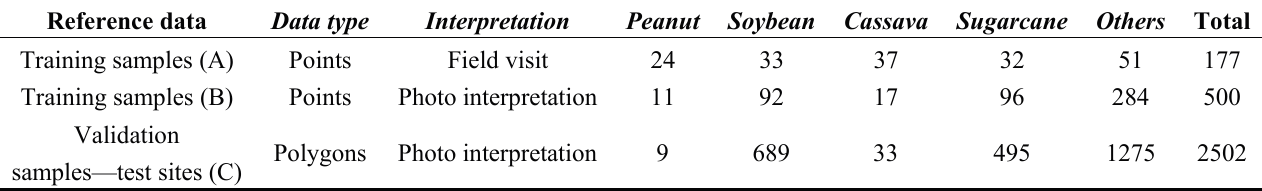
Table 3. Summary of available reference samples for training (A and B) and validation (C) (visually